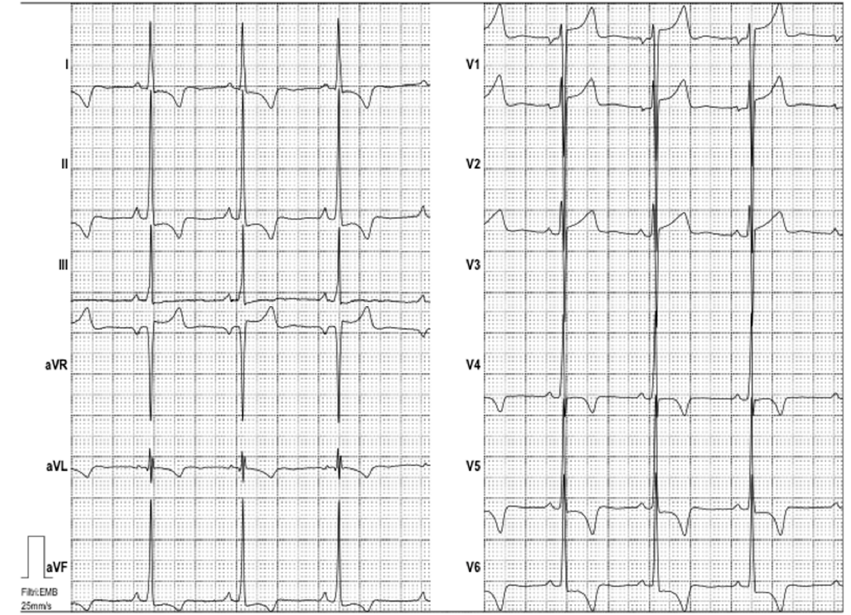
Figure 2. Electrocardiogram. Electrocardiogram showed sinus rhythm and high voltages of QRS with inverted T waves both in the peripheral and precordial leads, suggesting left ventricular hypertrophy.